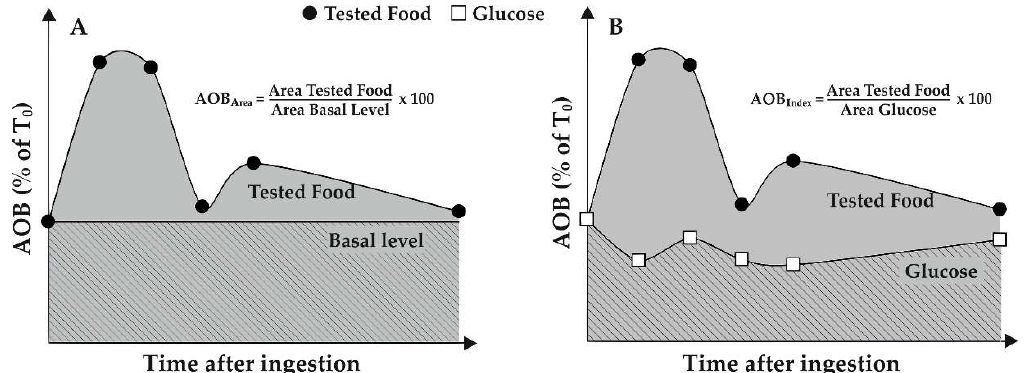
Figure 4. Calculation of AOB-Area and AOB-Index after food consumption. Hypothetical AOB profiles relative to both a generic food and glucose intake are reported. ( A ) AOB-Area is calculated as a ratio (%) between the area under serum AOB (expressed as % of T 0 value, i.e., value obtained before food intake) profile vs time (grey colored area) and the area below the baseline (crossed area), i.e., area below value at the baseline (T 0 ). ( B ) AOB-Index is calculated as a ratio (%) between the area under AOB profile and the area obtained after glucose (50 g) ingestion (crossed area).